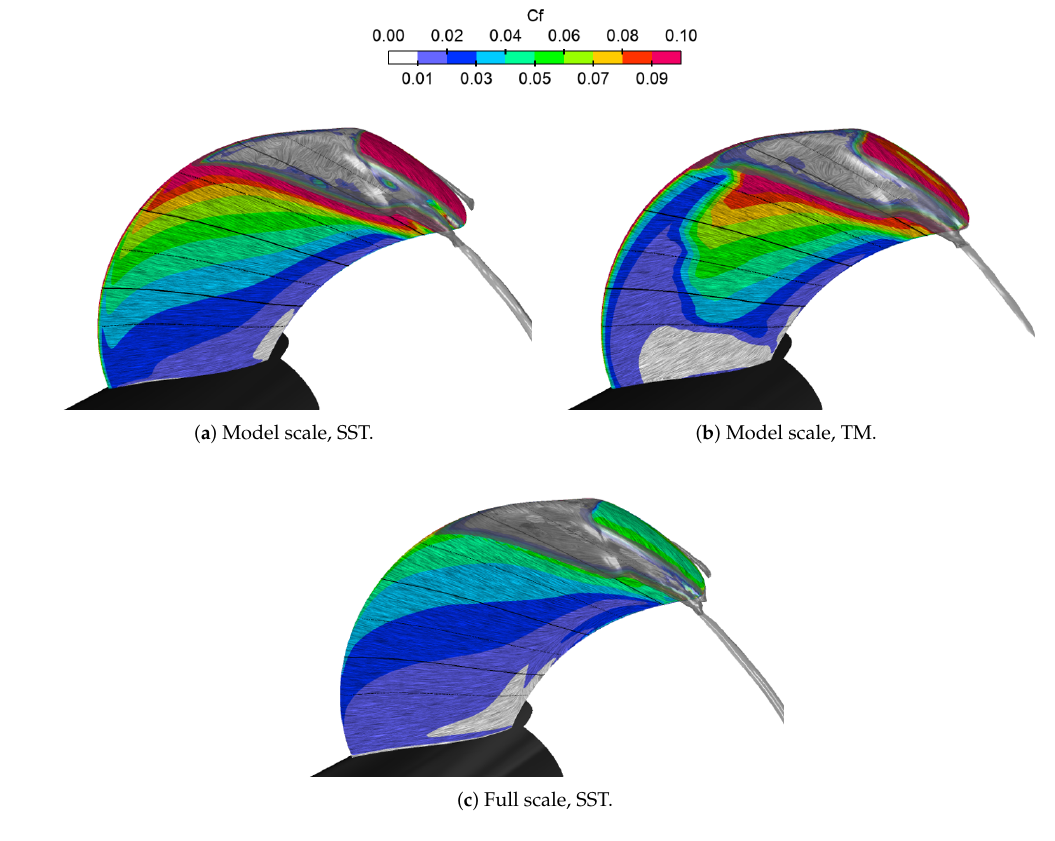
Figure 34. Comparison of near-blade skin-friction for